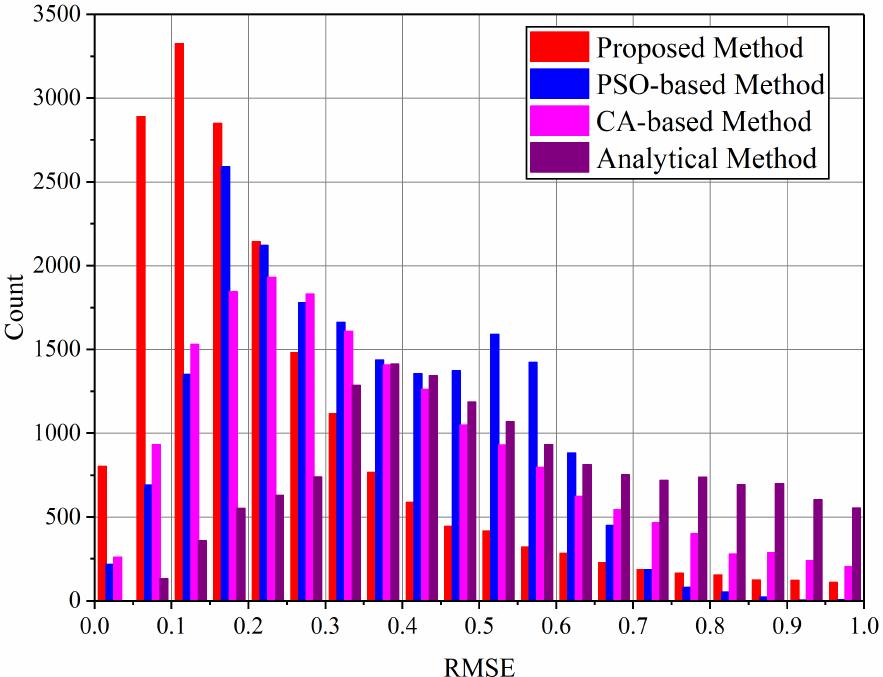
Figure 5. Distribution of annual accuracy of modeling based on different model parameter extraction methods.